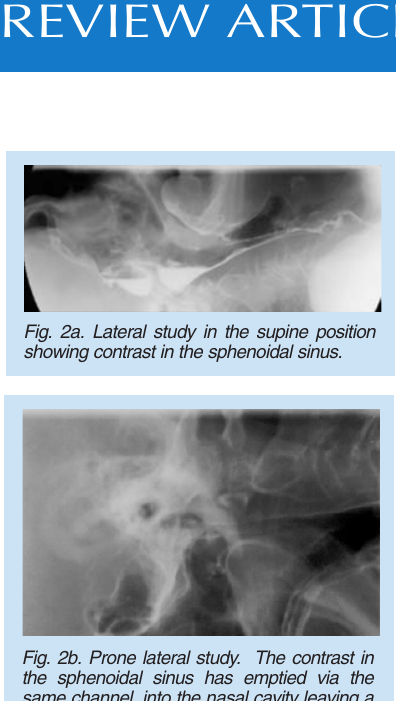
the oesophagus to accept contrast bolus, with consequent reflux into the nasopharynx.